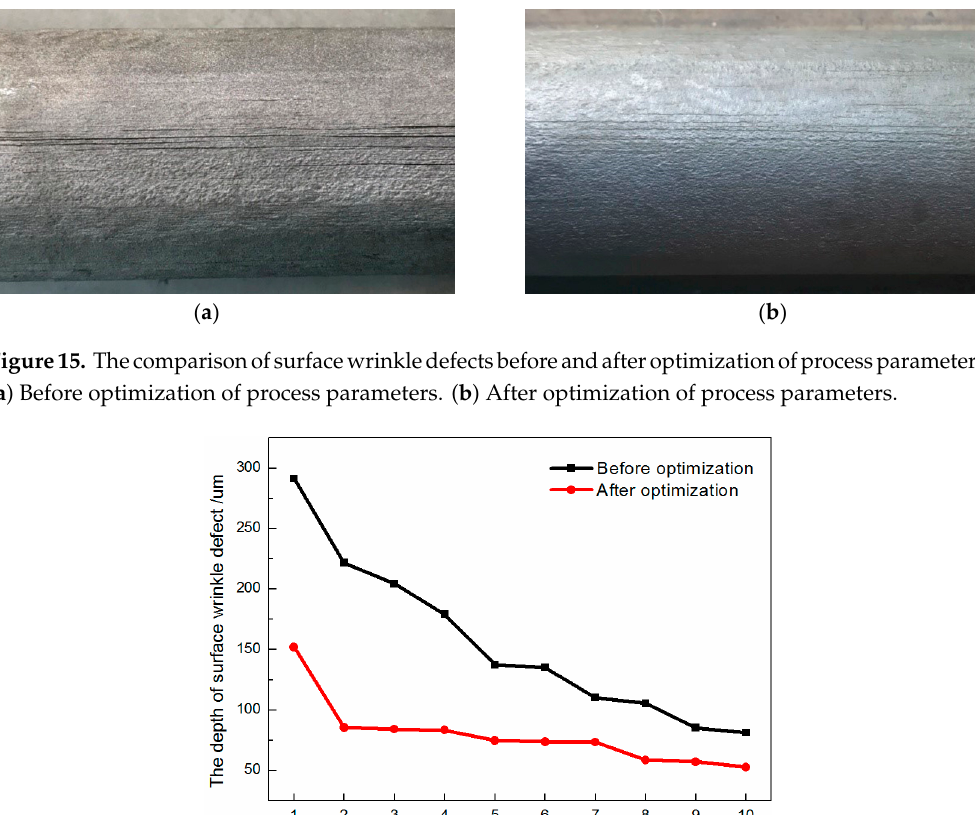
Figure 14. The morphology of surface wrinkle defects located at different positions and its distribution. ( a – d ) represent the morphology of surface wrinkle defects located at area 1, 3, 4 and 5, respectively. ( e ) The distribution of surface wrinkle defects in the cross section of the billet.